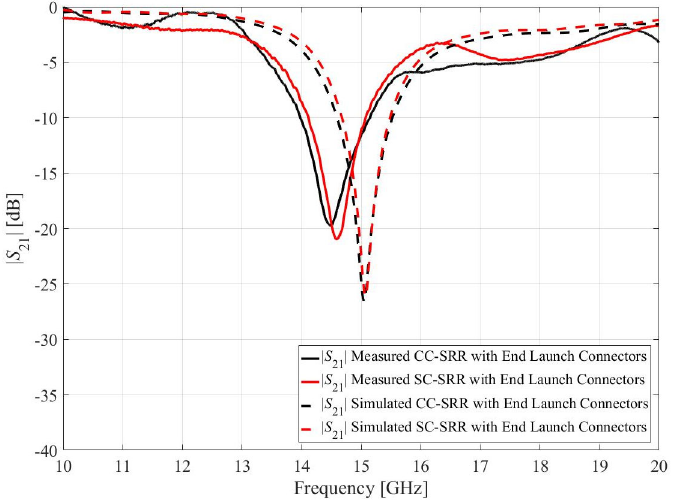
Figure 10. Measured and simulated transmission coefficients ( S 21 ) of the optimized sensors with end launch connectors.